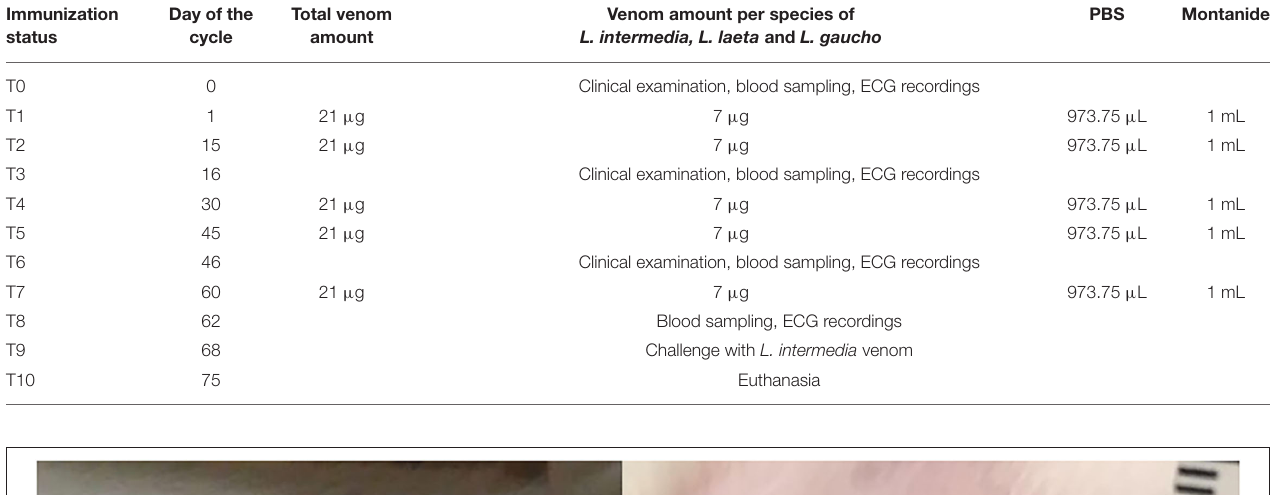
TABLE 1 | Immunization protocol of rabbits from venom group (VG) using Loxosceles venom. Immunization status